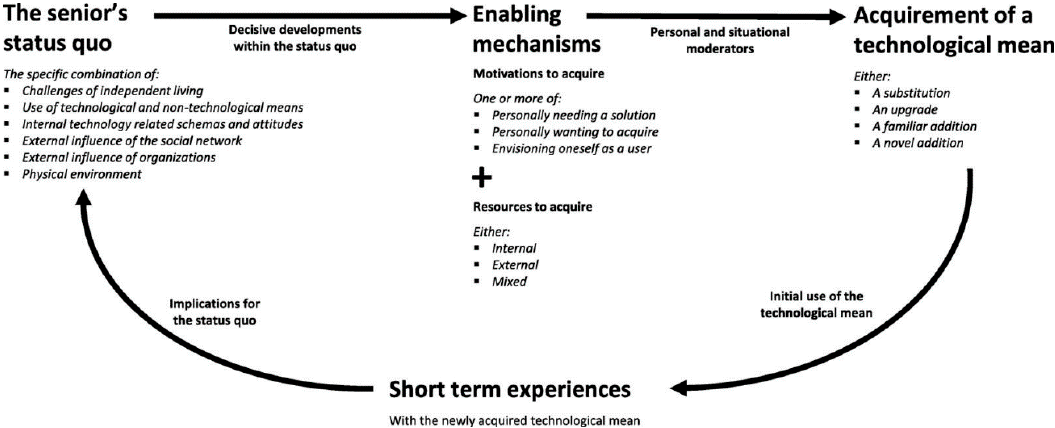
Figure 2. Cycle of Technology Acquirement by Independent Living Seniors (the C-TAILS model).